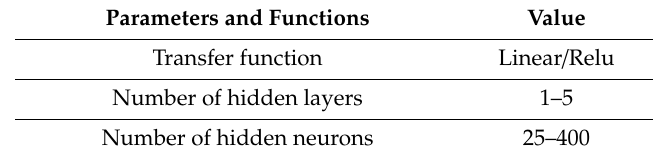
Table 3. Parameters and functions associated with the ANN forecast model.